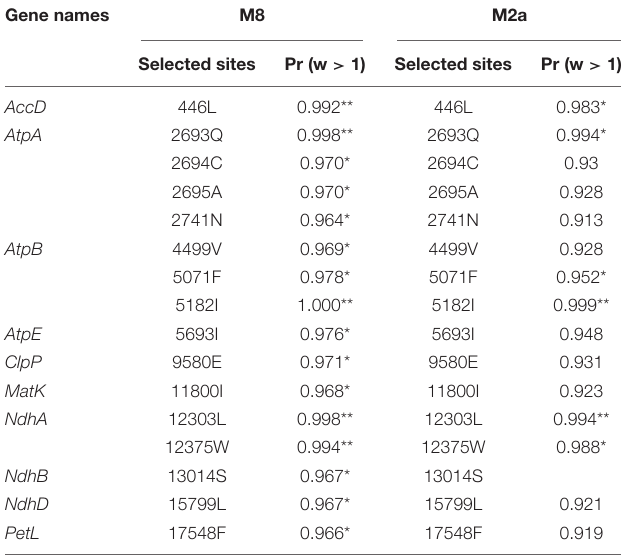
TABLE 2 | Positive selected sites detected in the cp genomes of